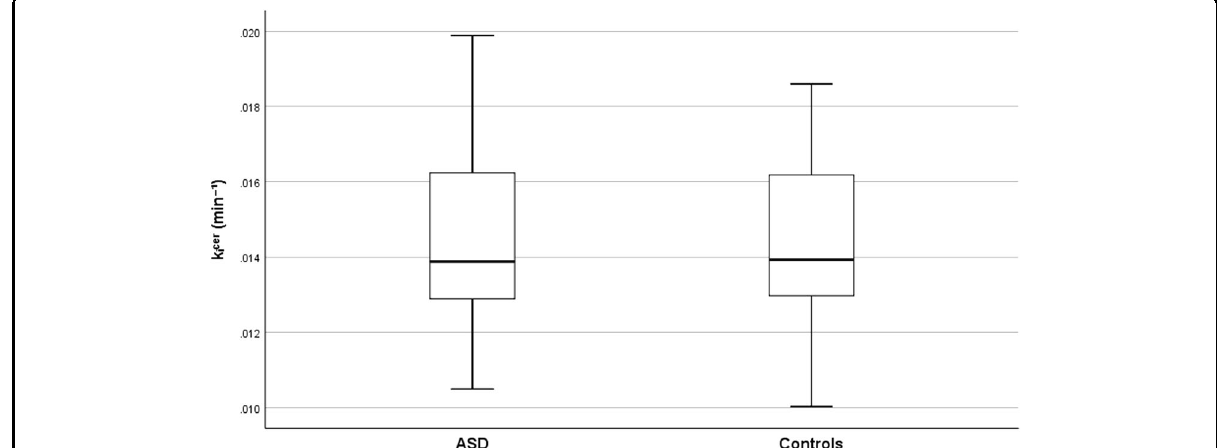
Fig. 1 Striatal dopamine synthesis capacity in adults with autism spectrum disorder (ASD) and controls. Boxplots show the median, quartiles, and range of striatal presynaptic dopamine synthesis capacity ( k icer min -1